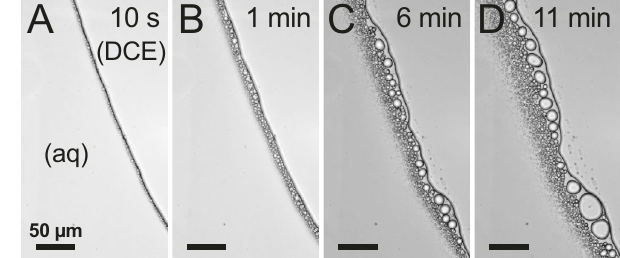
Fig. 2 | Light microscopy images of the liquid|liquid interface over time. Light microscopy images of the 10mM HAuCl 4 +1M NaCl (aq)|0.1M [NBu 4 ][ClO 4 ] (DCE) interface at A 10s, B 1min, C 6min, and D 11min after initial contact of the two phases. Scale barfor all images is50 µ m. All optical micrographs were taken with a ×40 NA 0.60 objective and a 500ms exposure